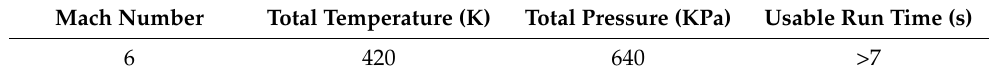
Figure 5. Schlieren and pressure measurement set-up.